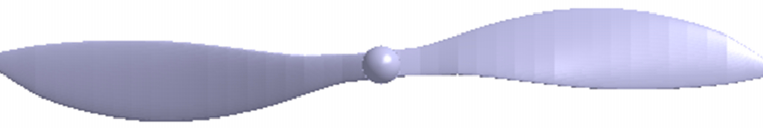
Figure 1. Standard APC Slow Flyer 10 inches × 7 inches propeller blade.